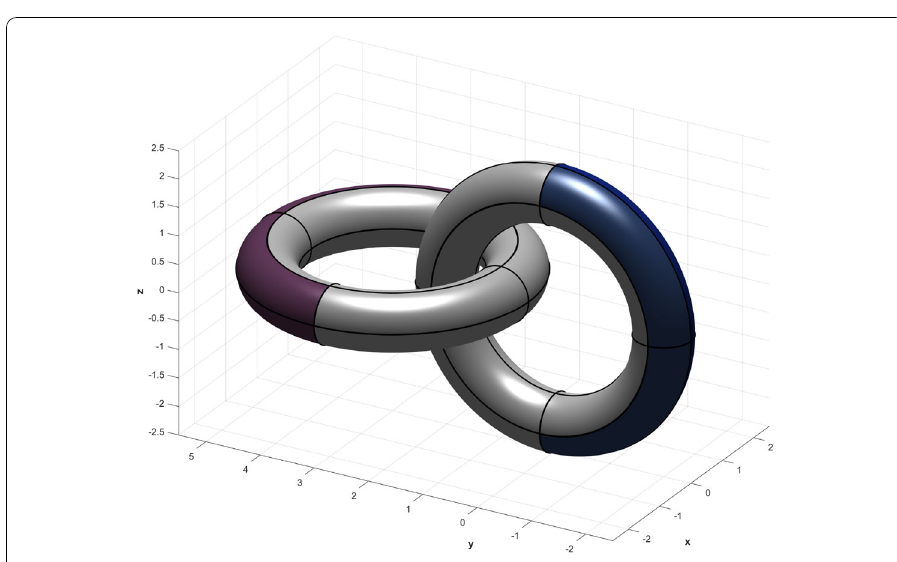
Fig. 11 Example 2. Contact simulation between curved surfaces. A positive displacement along the y direction is imposed over the purple surfaces. All the DOFs are constrained over the blue surfaces